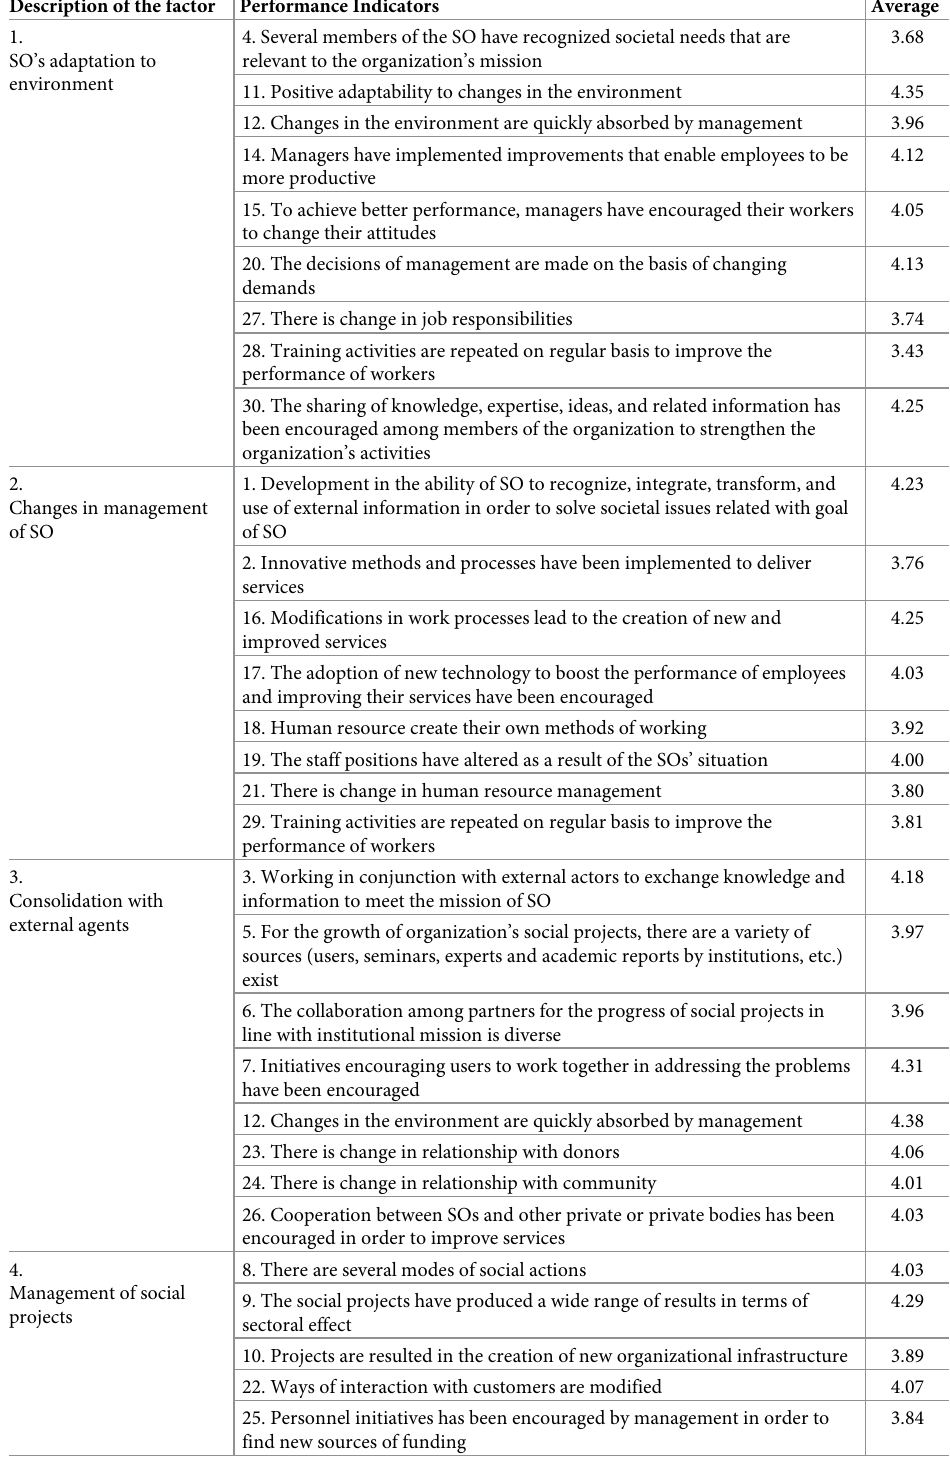
Table 8. Grouping of variables based on square